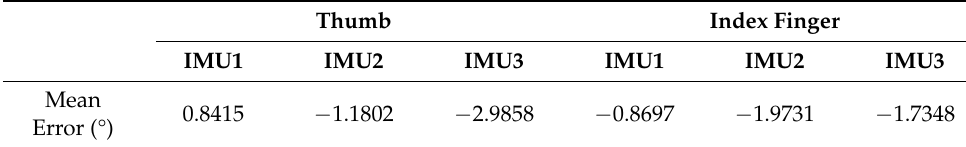
Table 2. The mean error of the dynamic tests for the thumb and index